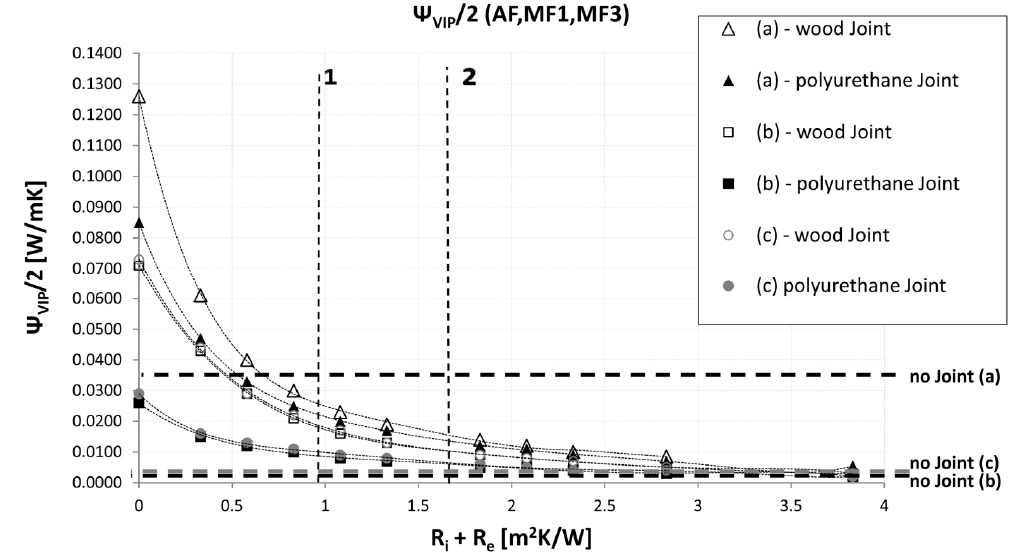
Figure 7. ψ VIP /2 values (1000 mm × 600 mm VIP